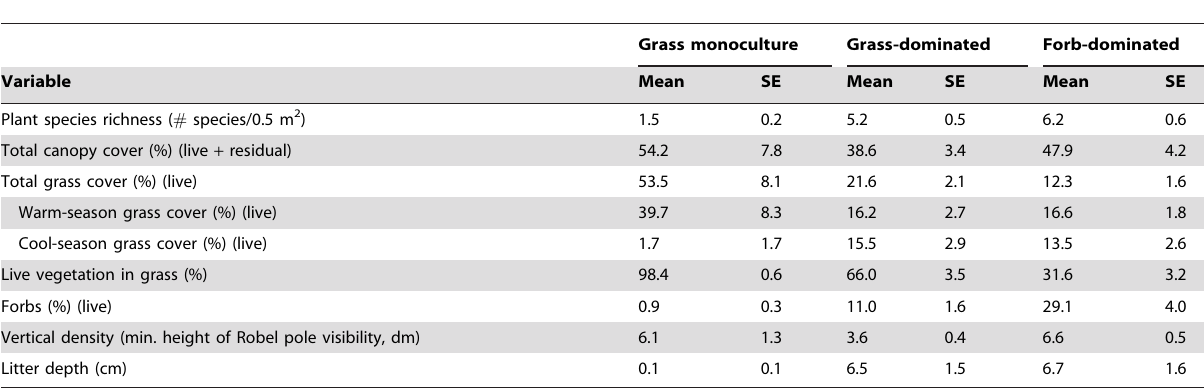
Table 1. Descriptive statistics of vegetation variables in the three grassland field types a .